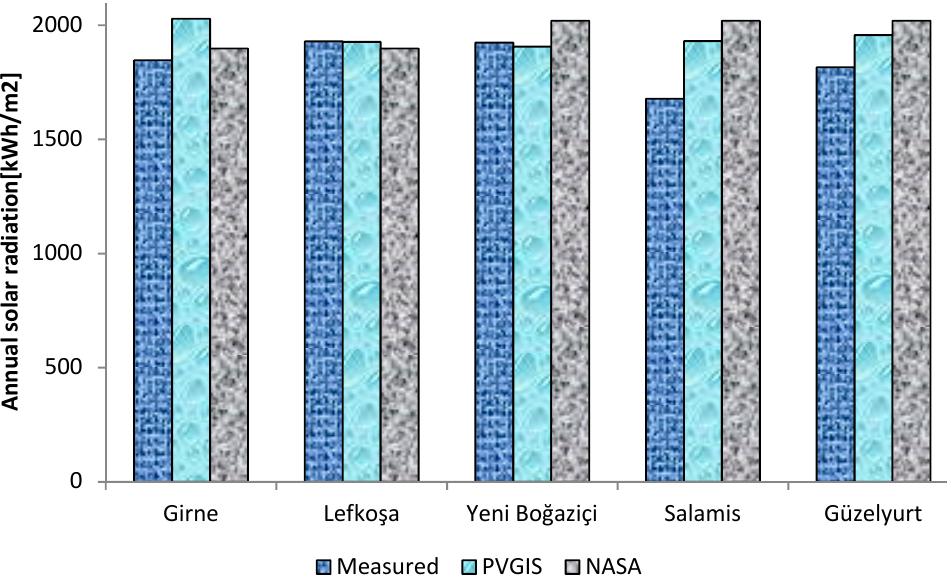
Figure 8. Annual solar radiation for all selected locations.